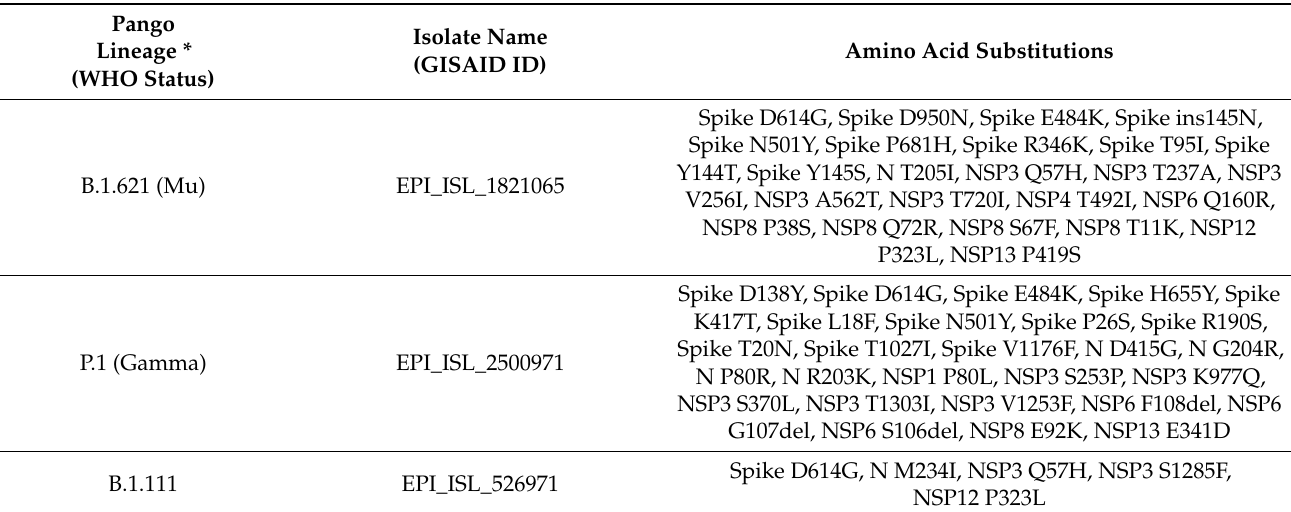
Table 1. Genomic characteristics of the viral isolates selected for MN 50 assays.